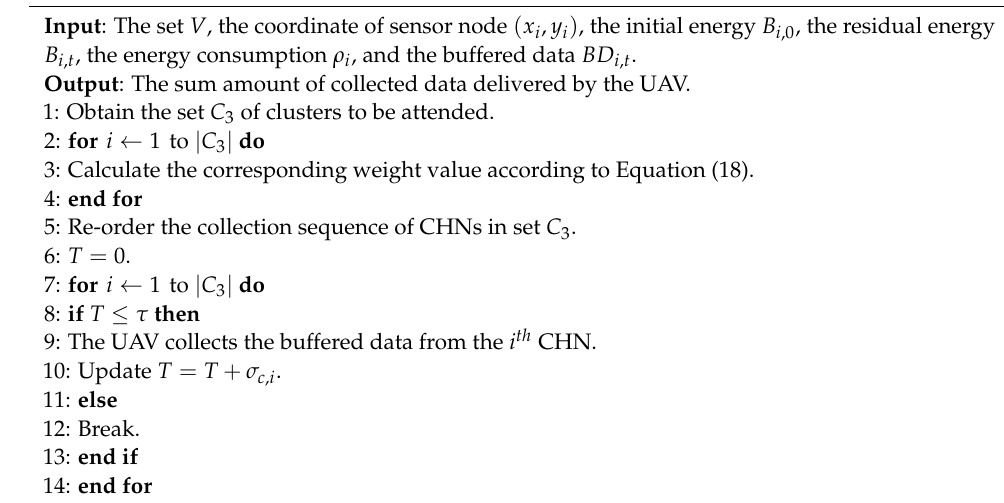
Algorithm 2. An efficient data collection